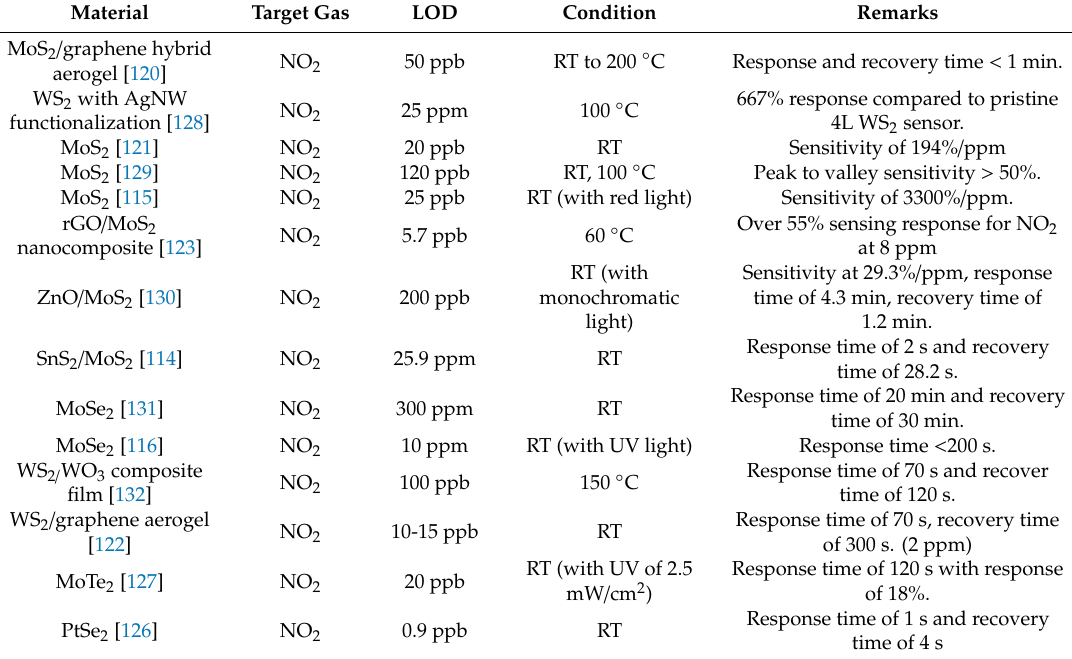
Table 1. NO 2 sensing TMDC materials and their performances.